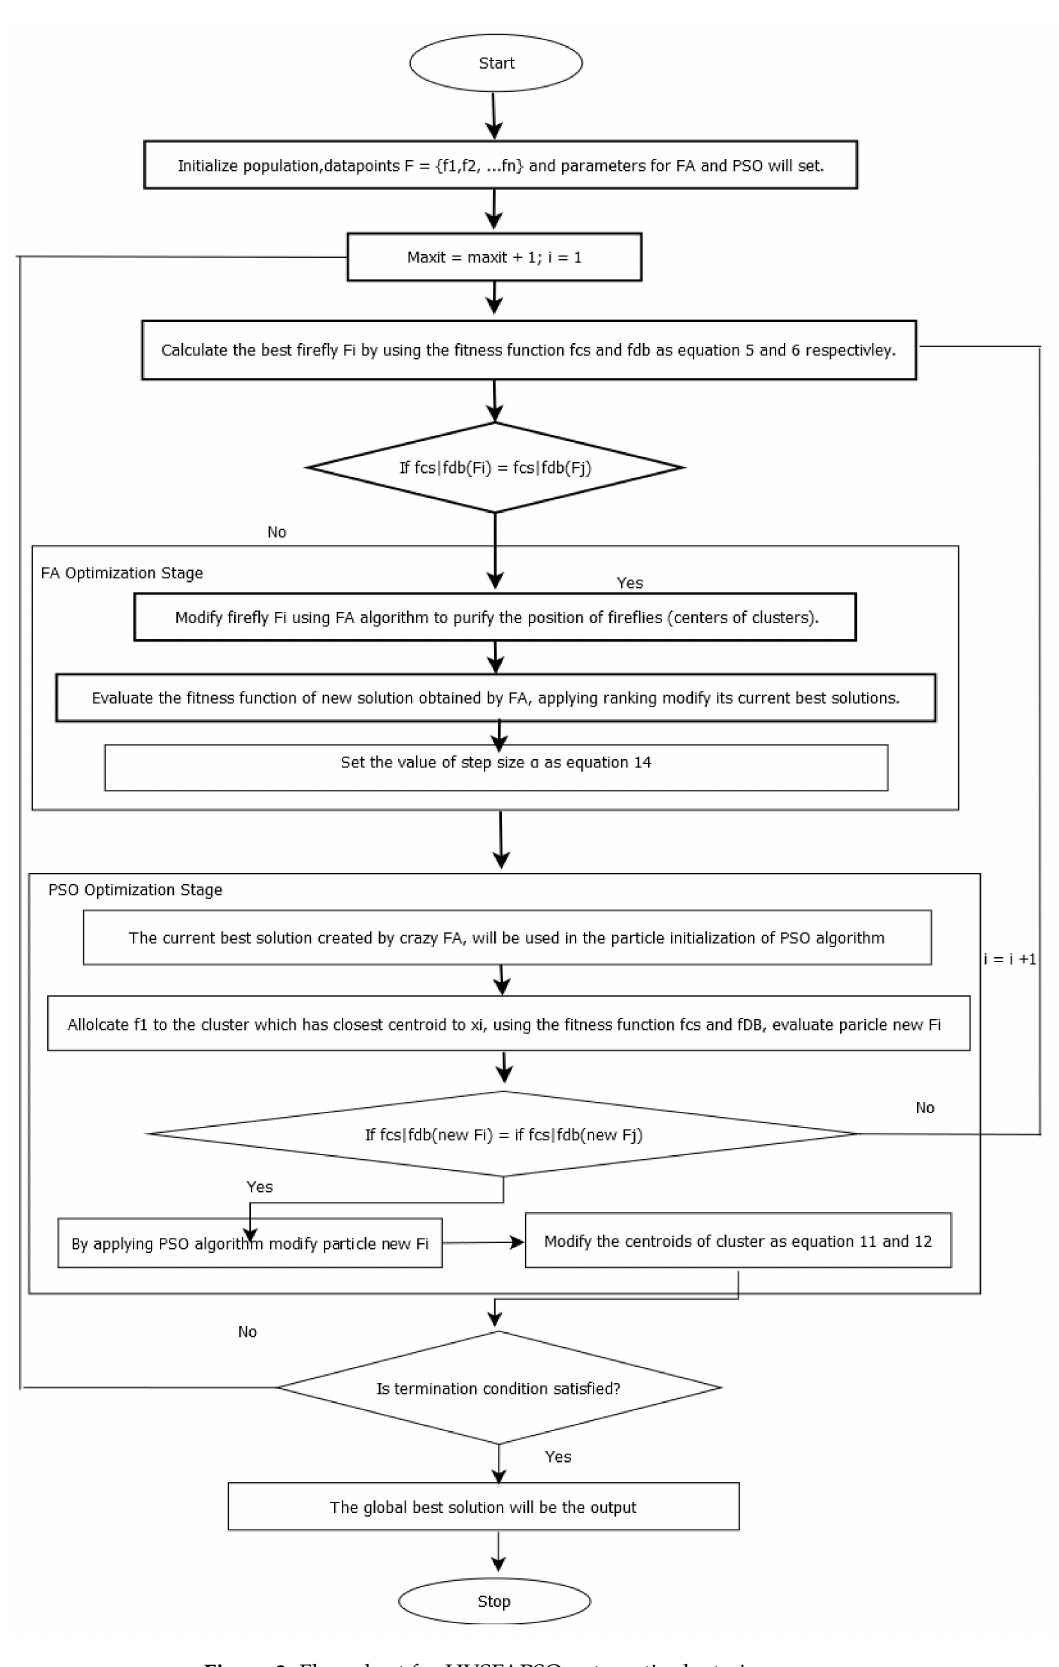
Figure 2. Flow chart for HVSFAPSO automatic